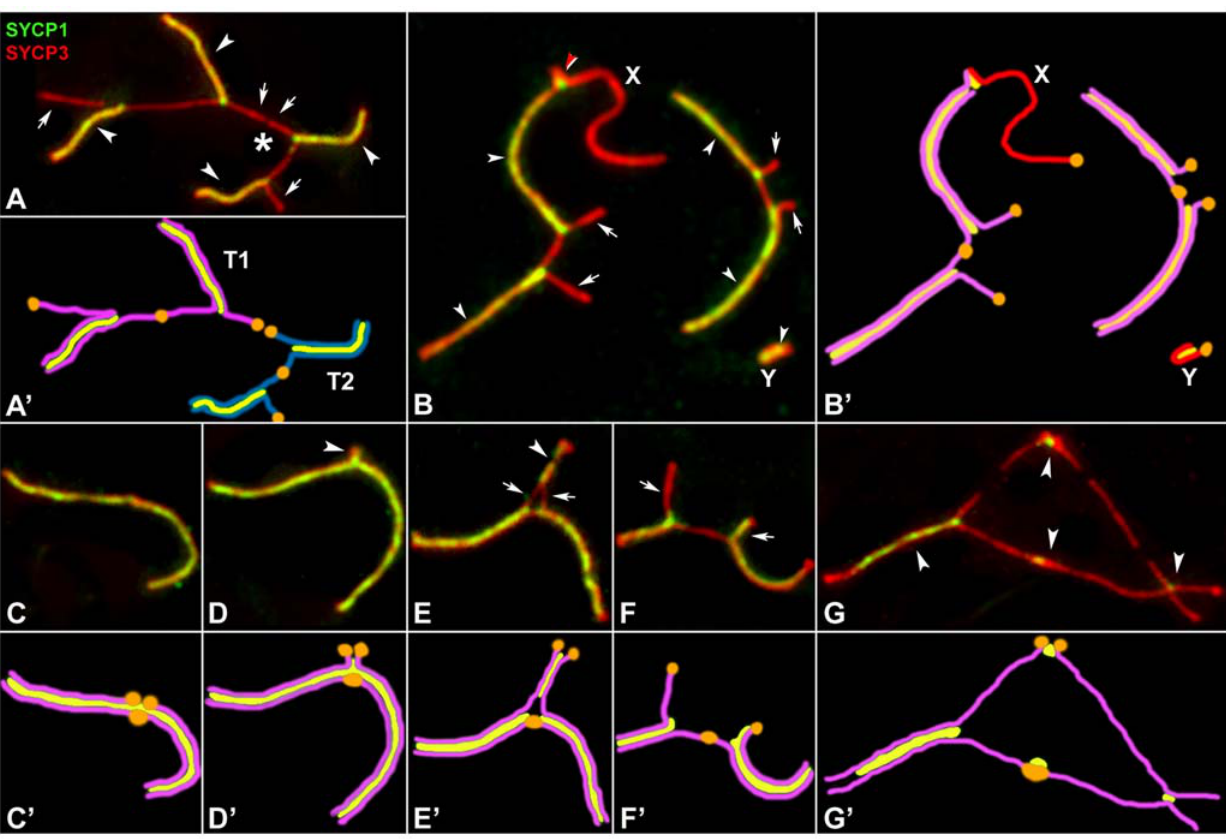
Figure 2. Synaptic conditions of Robertsonian trivalents during prophase-I. SYCP3 (red) and SYCP1 (green). (A,A’) Zygotene trivalents (T1 and T2) and their schematic representation. The distal ends of the acrocentric chromosomes are synapsed with the metacentric chromosomes (arrowheads) whereas the proximal ends are unsynapsed (arrows). Two unsynapsed proximal ends are engaged in a heterologous end-to-end connection (asterisk). (B,B’) Early pachytene. Trivalents show co-localization of SYCP3 and SYCP1 in the synapsed regions (arrowheads) whereas unsynapsed regions (arrows) that do not present SYCP1. One trivalent is associated with the X chromosome by a short segment of SC (red arrowhead). The single Y chromosome appears self-synapsed. (C,C’) Complete homologous synapsis of two acrocentric chromosomes with the metacentric chromosome. (D,D’) Heterologous synapsis between two acrocentric chromosomes involving a small chromosome region (arrowhead). (E,E’) Partial heterologous synapsis of the acrocentric chromosomes involving a long chromosome region (arrowhead). Notice the unsynapsed chromosomal segment in the heterologous region (arrows). (F,F’) Open trivalent. The proximal region of one acrocentric and the interstitial region of the metacentric chromosome do not present SYCP1, while the other acrocentric chromosome presents SYCP1 in its unsynapsed segment. (G,G’) During diplotene, the heterologous synapsis between acrocentric chromosomes persists (arrowheads) even when desynapsis begins in the trivalent.